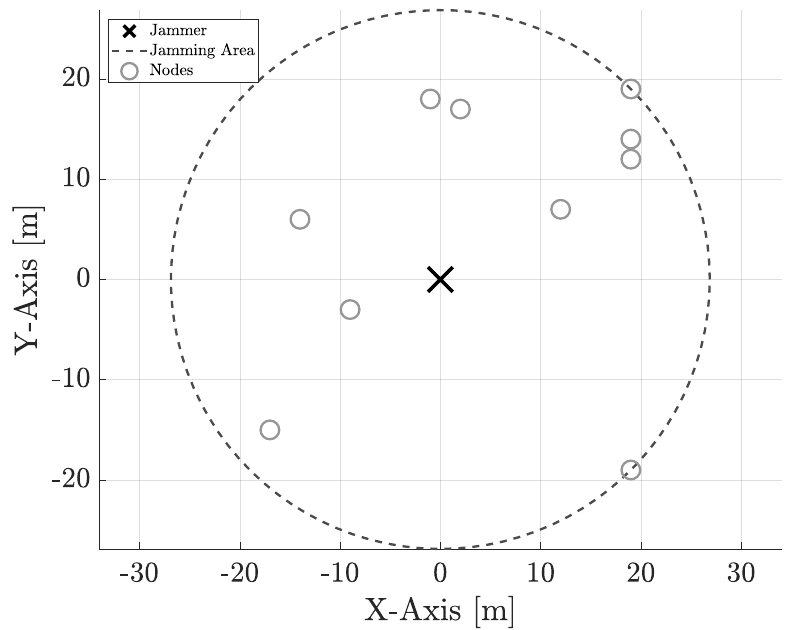
Figure 1. A typical random deployment: 10 nodes and the jammer (black cross) at the center of the scene. The black dashed circle represents the jamming